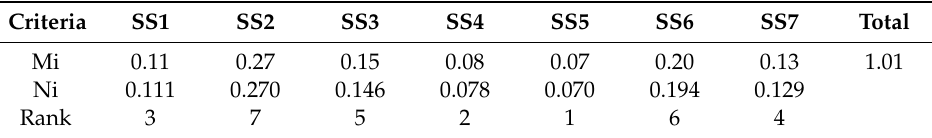
Table 6. The average, normalized weight, and rank of criteria for social sustainability.